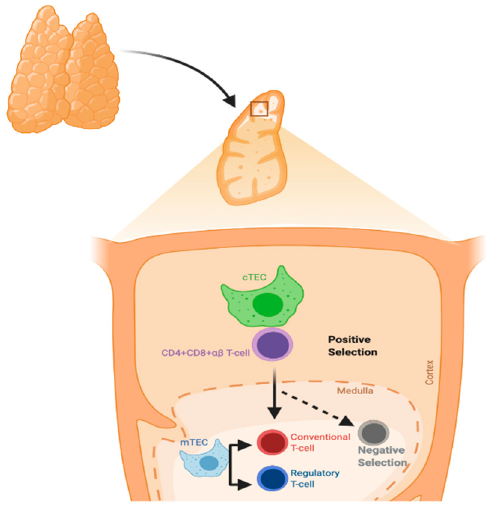
Figure 1. Process of T-cell selection in the thymus. Positive selection mainly occurs in cortical thymic epithelial cells (cTECs), whereas negative selection occurs in medullary TECs (mTECs). The major histocompatibility complex (MHC) molecules present neuroendocrine self-peptides to T-cells in the thymus. Self-reactive T-cell clones, i.e., T-cells recognizing the host molecules, are deleted and Treg cells are generated. Treg cells can inhibit self-reactive T-cells that evade thymic clonal deletion. Intra-thymic transcription is regulated by